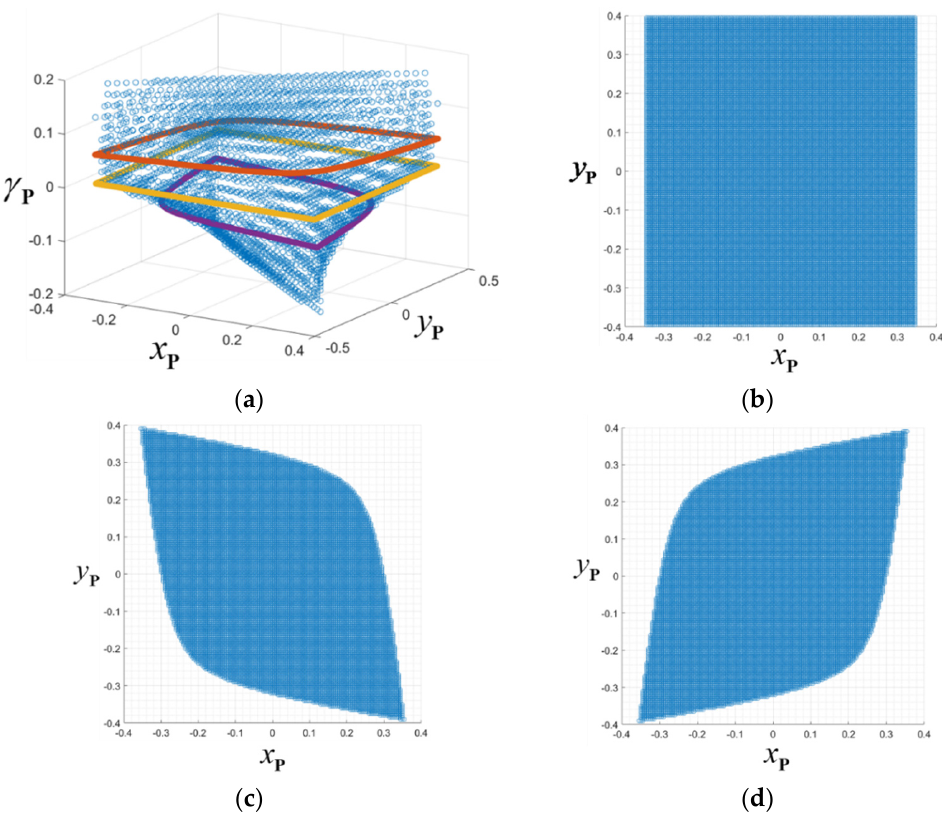
Figure 7. Wrench closure workspace of the first configuration shown in Figure 1. ( a ) Total orientation WCW; ( b ) 0 rad-section; ( c ) 0.052 rad-section; ( d ) − 0.052 rad-section.